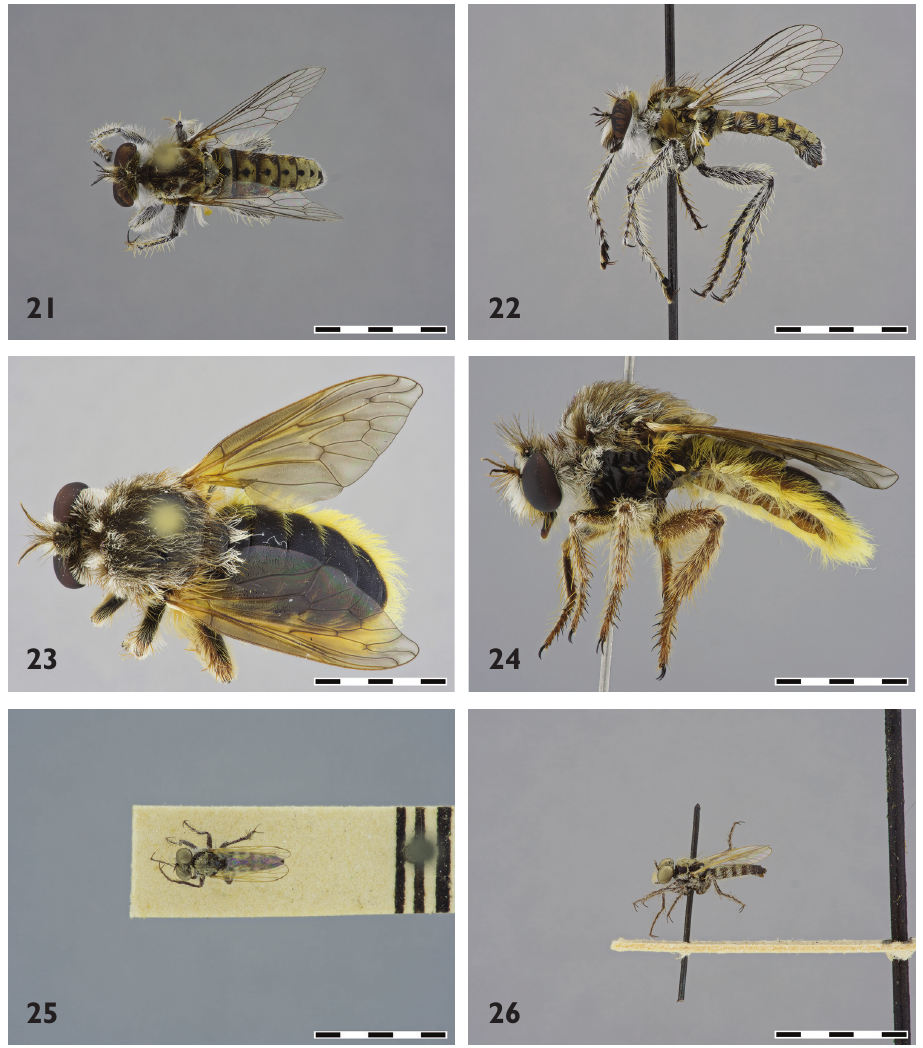
Figures 21–26. Photographs of Willistonininae: 21 male Ablautus sp. (AAM-004314), dorsal (Morphbank #860664) 22 same, lateral (#860666) 23 male Acnephalomyia sp. (USNMENT01115145), dorsal (#860685) 24 same, lateral (#860687) 25 female Ammodaimon sp. (USNMENT00995300), dorsal (#860693) 26 same, lateral (#860695). Scale bars: 5